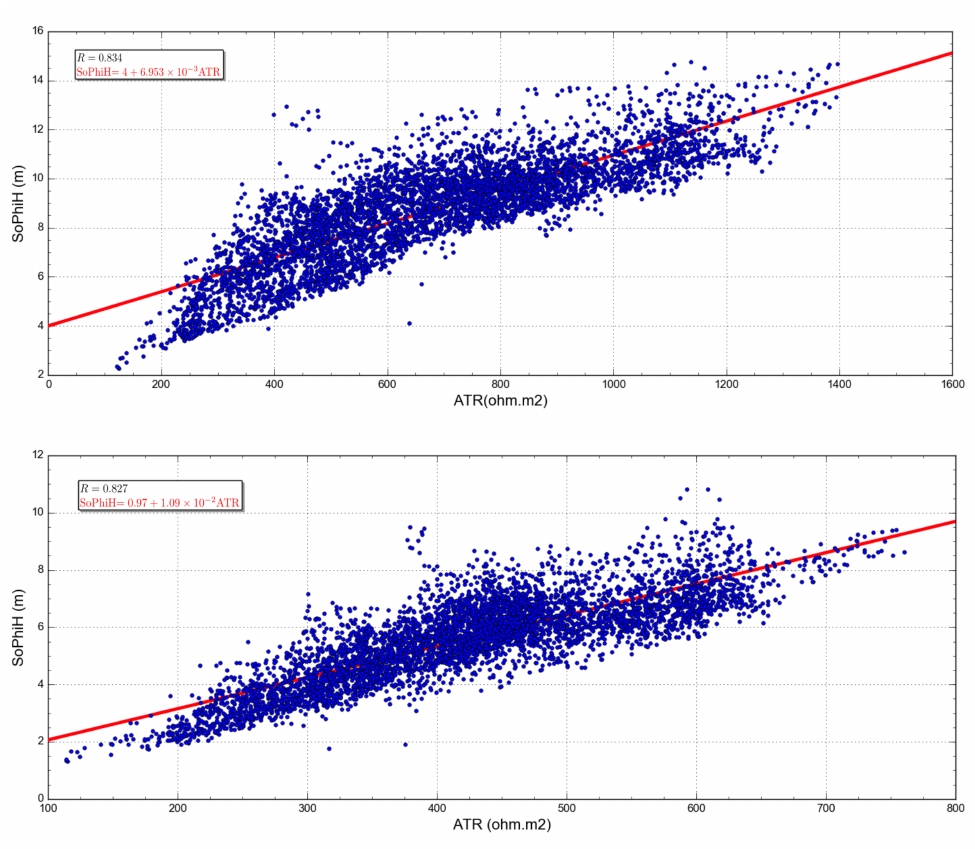
Figure 13. Relation between the ATR recovered from the CSEM inversion (Figure 10) and the true SoPhiH (Figure 11) calculated from the flow simulation. The red line shows the best least-square fit to the data (blue circles). ( Upper panel ) The 2021 base year with a correlation coefficient R of 0.834. ( Lower panel ) The monitoring year 2031 with a correlation coefficient R of